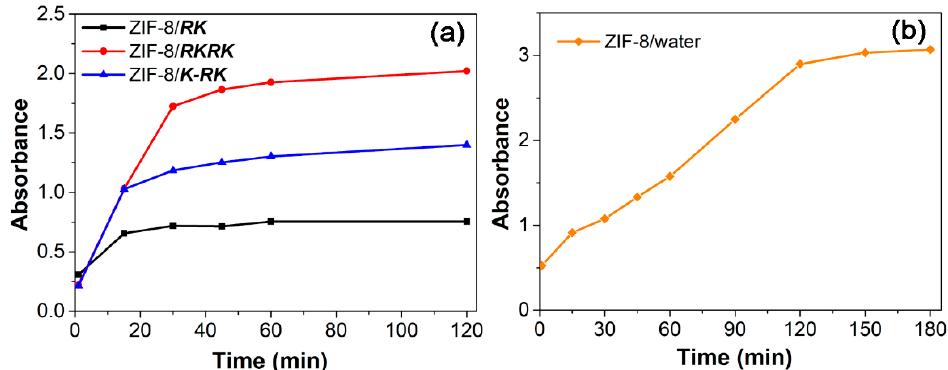
Figure 6. Variation of the solution turbidity with the elapse of reaction time during synthesis of ZIF-8 in the presence ( a ) or absence ( b ) of different peptides.